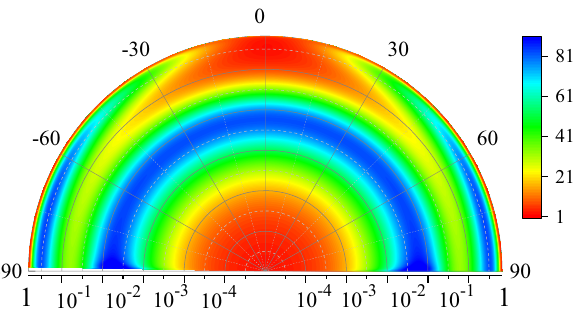
Figure 9. Colour-density plot for absorptivity ratio r p as a function of frequency ω and scattering angle θ in 2 1.84 10 plasma for α − = ×